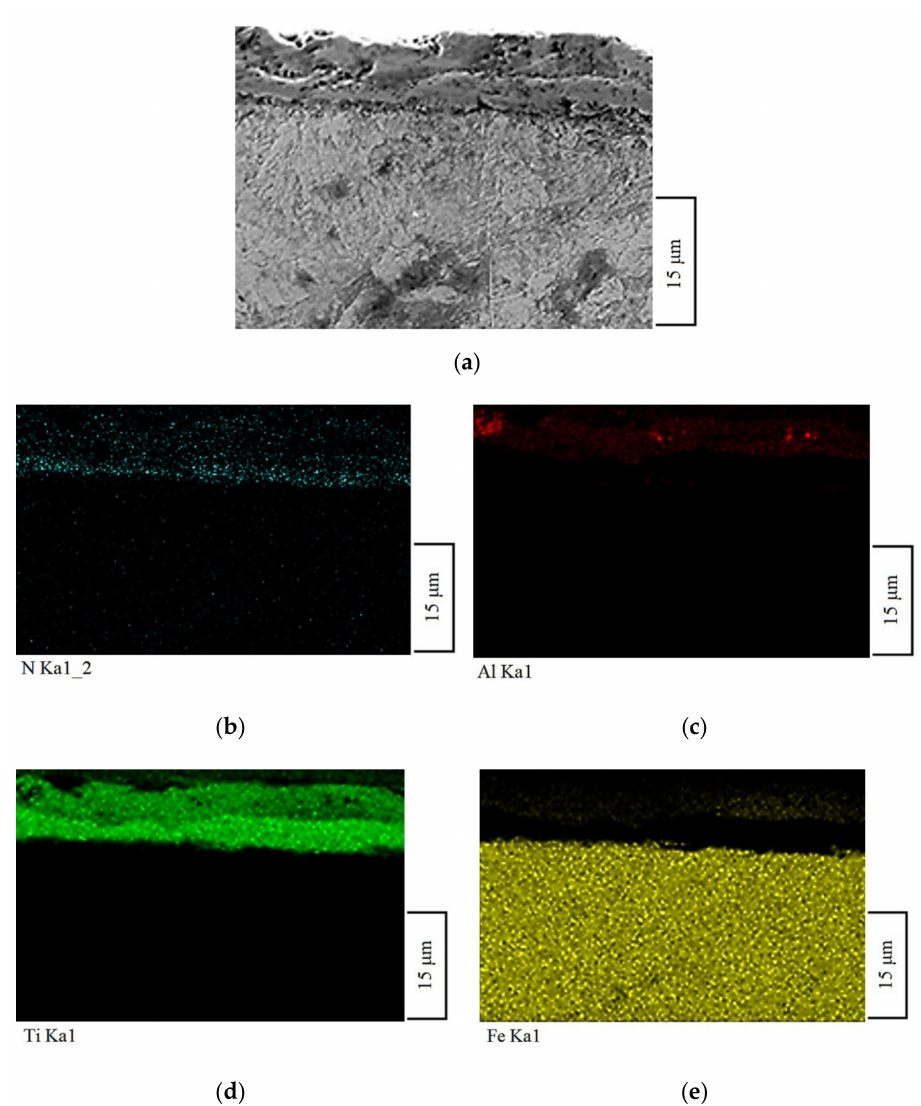
Figure 5. Microstructure in reflected electrons ( a ) and distribution map of elements along the plane of grinding on AISI W1-7 steel (characteristic X-ray radiation in secondary electrons) for N ( b ), Al ( c ), Ti ( d ), Fe ( e ) after nitrous titanium aluminizing: nitriding (540 ◦ C, 36 h), titanium aluminizing (1050 ◦ C, 4